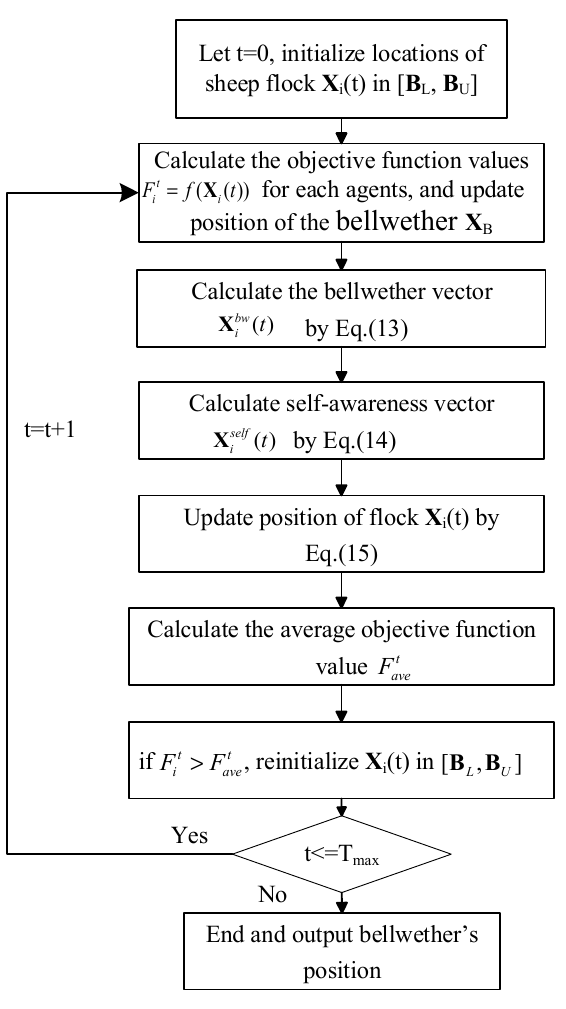
Figure 7. Flowchart of ASA optimization.